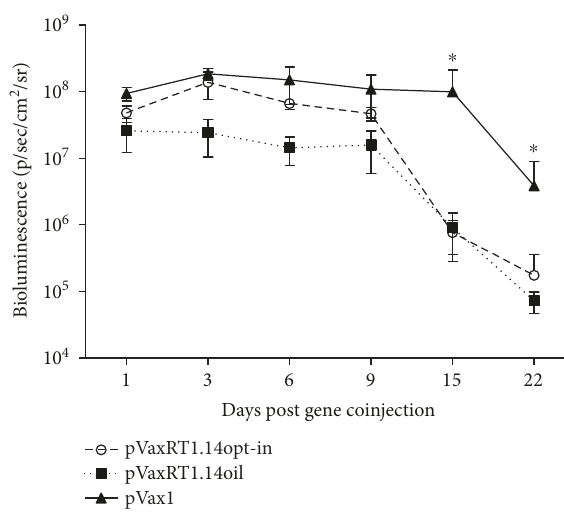
Figure 9: Kinetics of in vivo bioluminescence from the sites of coadministration of RT genes and luciferase reporter genes. In vivo monitoring of luciferase activity on days 1, 3, 6, 9, 15, 22 after the administration of plasmids encoding RT1.14opt-in and RT1.14oil, or empty vector pVax1, each mixed with pVaxLuc encoding fi re fl y luciferase (1 :1 w / w ). One curve represents bioluminescent emission from eight mice with two immunization sites in each, assessed in two independent immunization runs. ∗ p < 0 05 (Mann – Whitney